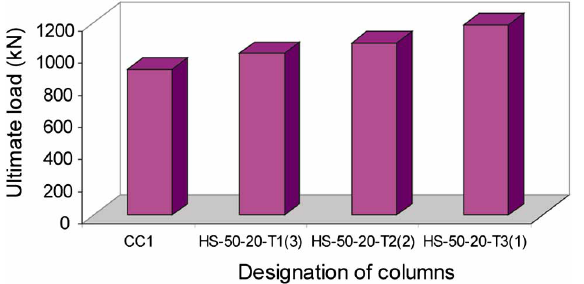
Fig. 17. Ultimate load for columns HS-50-20 (cid:1) comparison